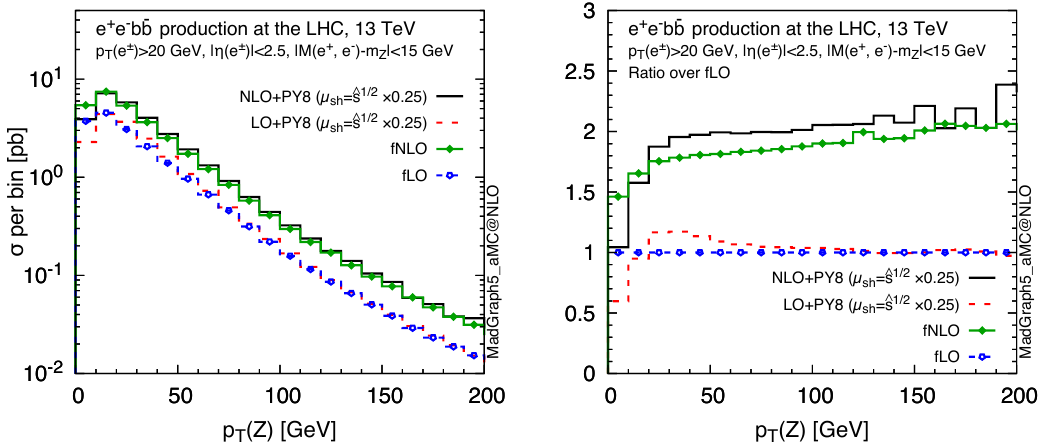
Figure 6 . p ‘ + ‘ (cid:0) distribution in 4FS inclusive over the b -quarks contribution: comparison of ? predictions in di(cid:11)erent perturbative approximations: LO, NLO, LO matched with the Py8 QCD- PS, NLO matched with a QCD-PS (left panel) and relative impact of higher-order corrections relative to the LO prediction (right panel).